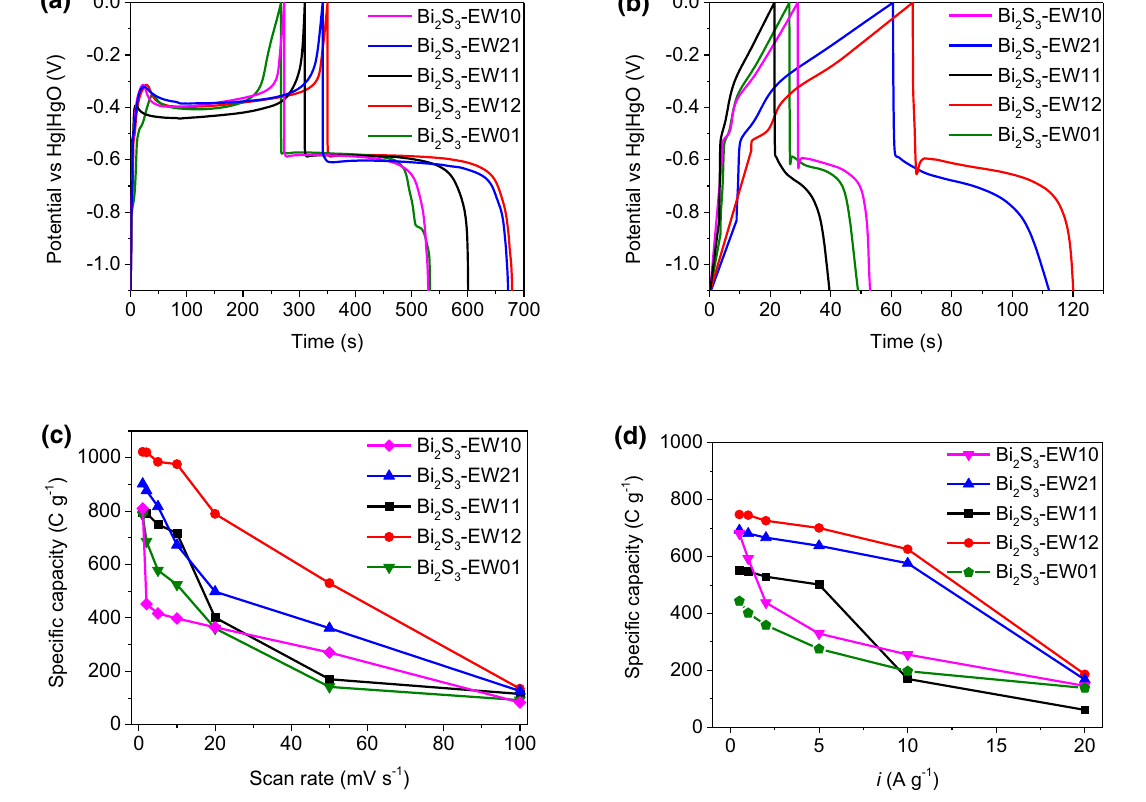
Fig. 6 Charge–discharge profiles of bismuth sulfide recorded at 2 A g −1 ( a ) and 10 A g −1 ( b ), and various specific capacity values of bismuth sulfides as a function of scan rate ( c ) and current density ( d )